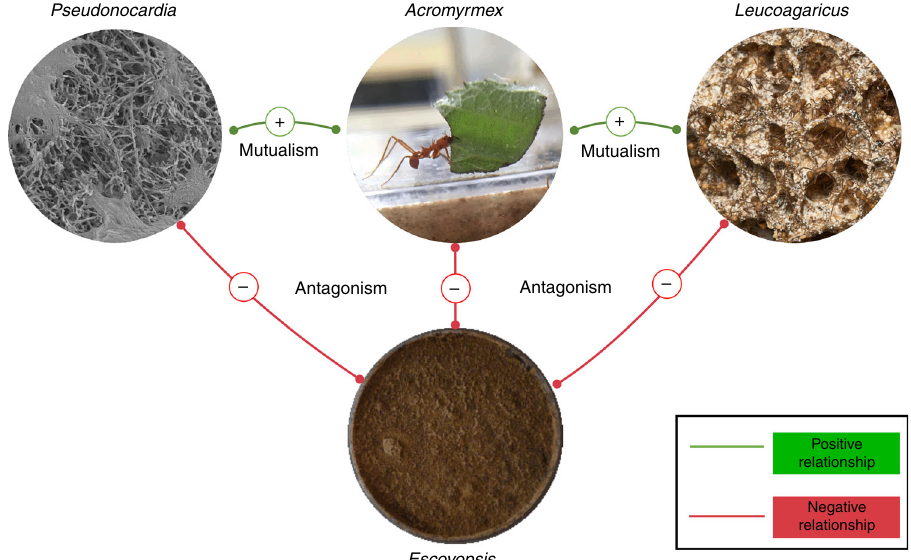
Fig. 1 Summary of the complex interactions between symbionts of Acromyrmex echinatior leafcutter ants. The ants feed their vertically transmitted bacterial mutualist strain of Pseudonocardia through tiny subcuticular glands and in return the bacteria provide antifungal compounds to kill the parasite Escovopsis . They feed cut leaf fragments to their clonal fungal mutualist Leucoagaricus gongylophorus and this fungus provides the sole food source for their larvae. The parasite Escovopsis also feeds off Leucoagaricus and if left unchecked can overrun and kill the fungal cultivar and the entire ant colony. To prevent this, worker ants groom their fungal cultivar to remove Escovopsis spores and sterilize them with antifungal compounds made by Pseudonocardia . In this work, we show that Escovopsis fi ghts back against the defensive mutualists by producing the virulence factors melinacidin IV ( 1 ) and shearinine D ( 2 ). Both compounds kill Pseudonocardia and 2 also adversely affects worker ant behavior and is ultimately lethal to the ants. The SEM of Pseudonocardia sp. spores on the surface of A. echinatior ant was taken by Dr. Kim Findlay (JIC); the images of the Acromyrmex ant and fungus garden were taken by Professor Matt Hutchings (UEA); the image of the Escovopsis plate was taken by Dr. Neil Holmes